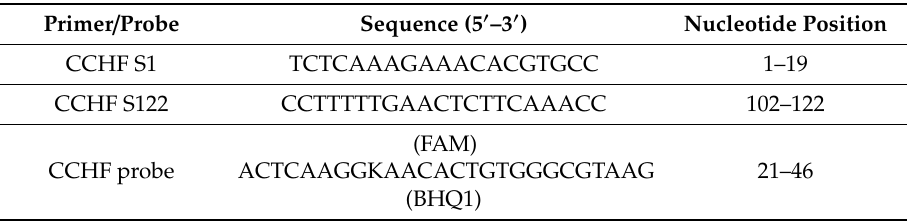
Table 3. Primers and probe information for the CCHFV RT dd-PCR assay based on Atkinson et al.’s